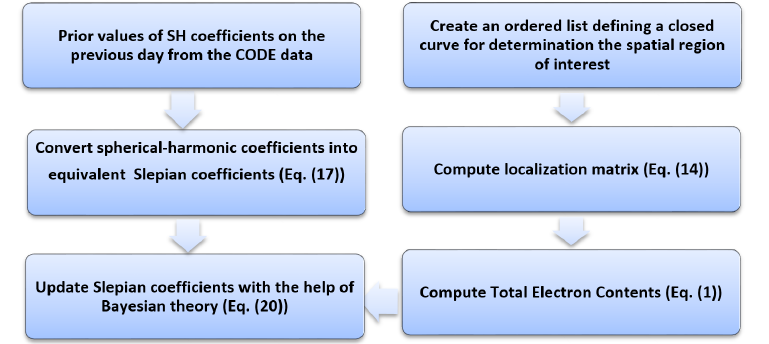
Figure 1. An overview of the proposed VTEC regionalization technique for positioning applications.